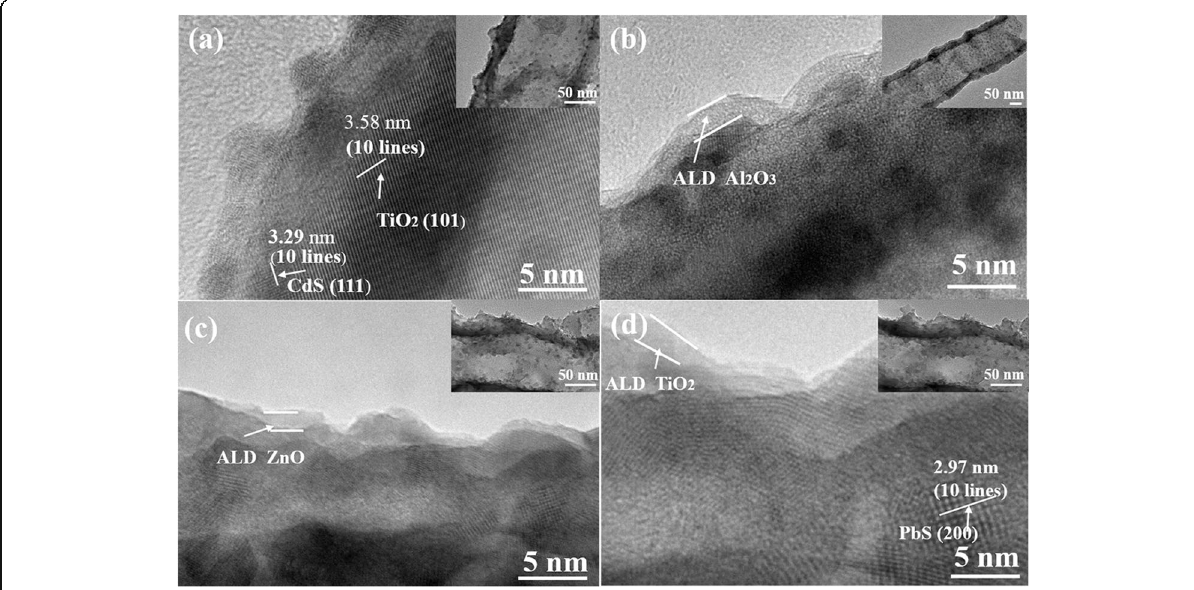
Fig. 2 TEM images of TNTAs/QDs with various ALD cycles overlayer: a 0 cycles, b 30 cycles Al 2 O 3 , c 10 cycles ZnO, and d 25 cycles TiO 2 . The insets are the corresponding low-resolution TEM